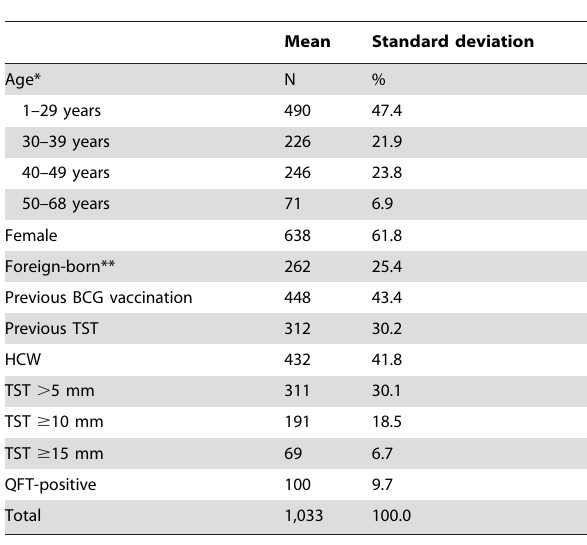
Table 1. Description of the study